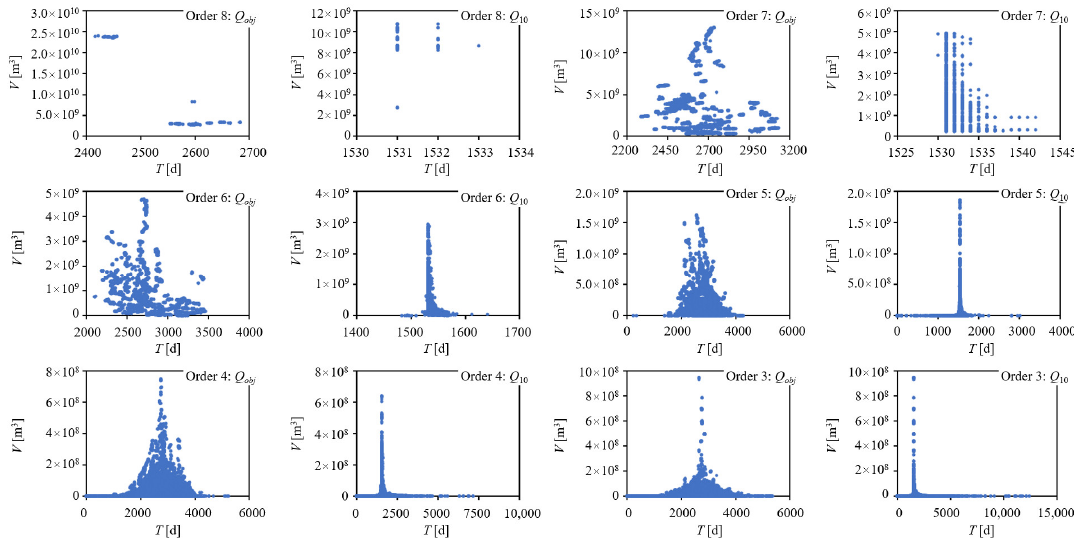
Figure 10. Duration time ( T ) with volume ( V ) for low flow relations in the studied rivers, according to their order and the threshold method